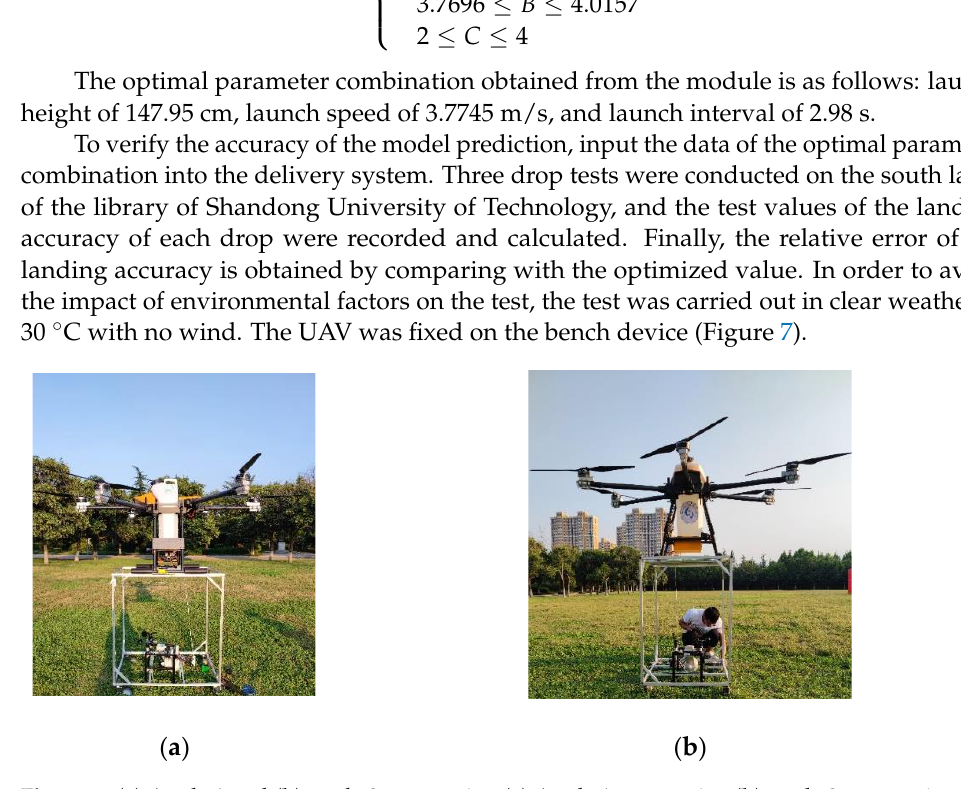
( b ) Figure 6. ( a ) Response surface and ( b ) contour plot for the interaction between launch velocity and